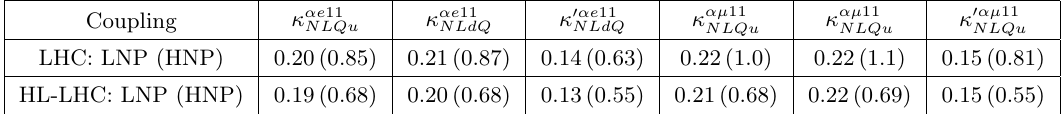
Table 2. Current and projected 90% C.L. bounds on the new physics coupling (cid:20) from LHC and HL-LHC data, respectively, for the LNP ((cid:3) = 1 TeV) and HNP ((cid:3) = 10 TeV)